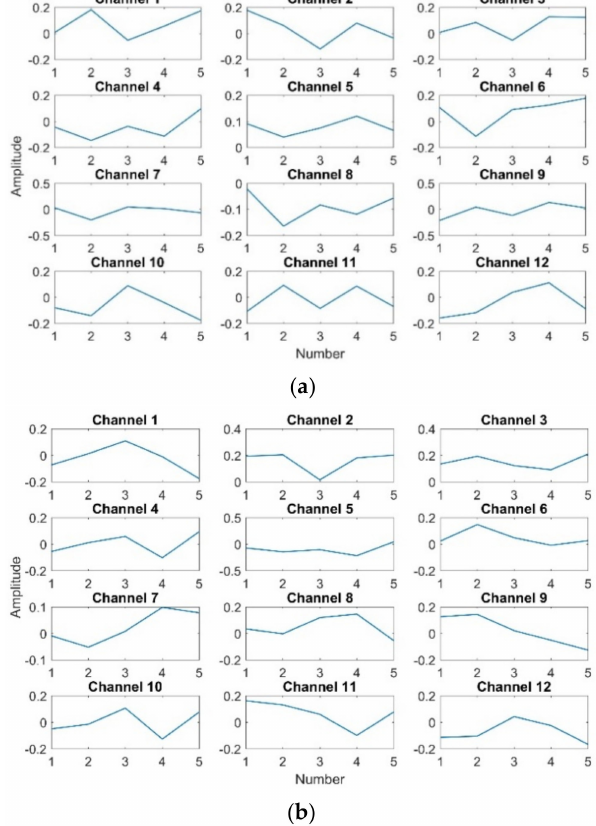
Figure 13. The curve of each channel. ( a ) Kernel 1 ( b ) Kernel 2. The visualizations of the two convolution kernels in the second convolutional layer are shown in Figure 14. Each column of convolutional kernel is called the channel. The convolution kernel in the second convolutional layer has 32 channels. The curves of the first twelve channels are shown in Figure 15.